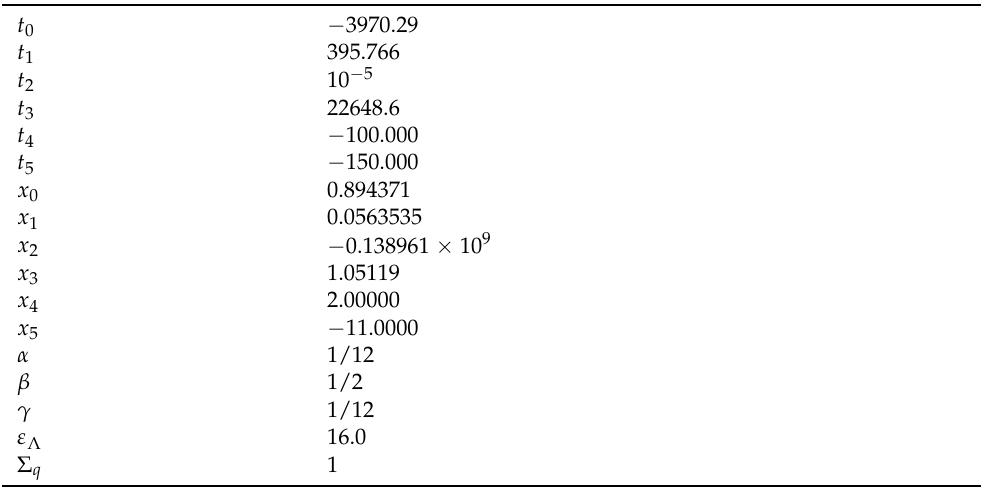
Table 1. Parameters of the functional BSk24 [18]. The unit of length is femtometer and the unit of energy is